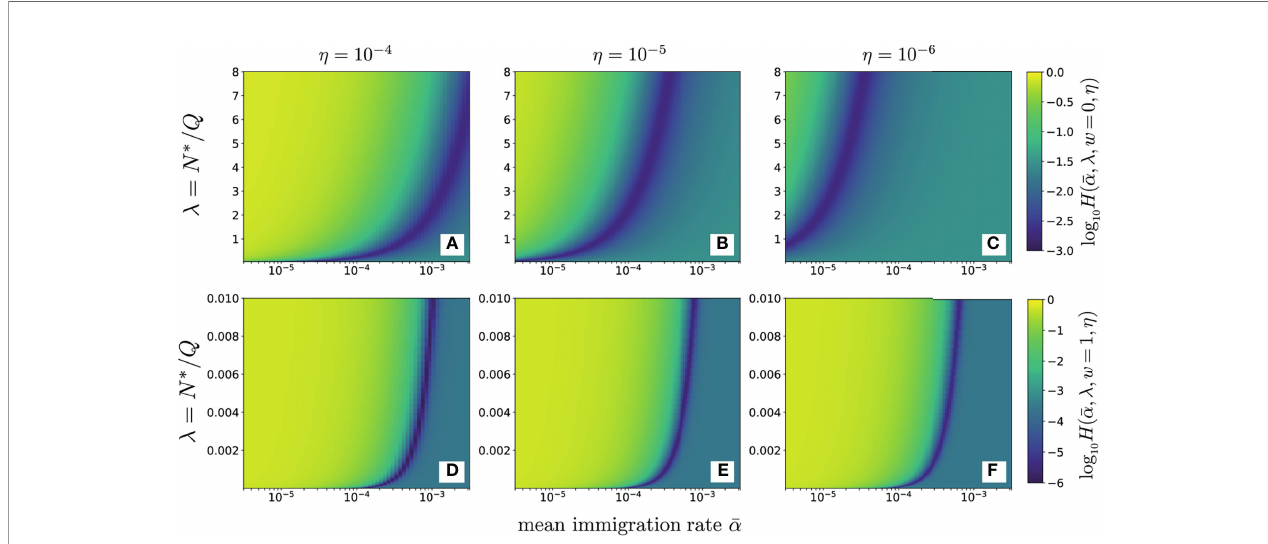
FIGURE 6 | The error H ( (cid:2) a , l , w , h ) plotted as a function of a (on a log 10 scale) and l . Darker colors represent smaller values of error as shown by the scale bar on the right. The data used are the clone counts of beta chain sequences of naive CD4 cells from one patient, averaged over three samples. Panels (A – C) use the simple neutral model (Eqs. S9 and S10) and sampling fractions h = 10 -4 , 10 -5 , and 10 -6 , respectively. Since (cid:2) a is on a log scale, the error is minimal along a line l min ∝ (cid:2) a ; the error does not change appreciably along this path and only slightly decreases as l and (cid:2) a become smaller. For the neutral model (w = 0), the error is very sensitive to the sampling fraction h . Here, a fi xed, physiologically reasonable value of (cid:2) a results in a minimizing l min that is unreasonably large, in excess of one and that does not agree well with our expectations of l = N ∗ = Q ≪ 1. Panels (D – F) show results for the distributed proliferation rate model at full width ( w = 1). In this case, the errors are insensitive to the speci fi c choice of h and the minimizing l min values are much smaller, consistent with our estimates of N ∗ and repertoire size. For w = 1, the values of the errors H are also smaller along the l min − (cid:2) a minimum